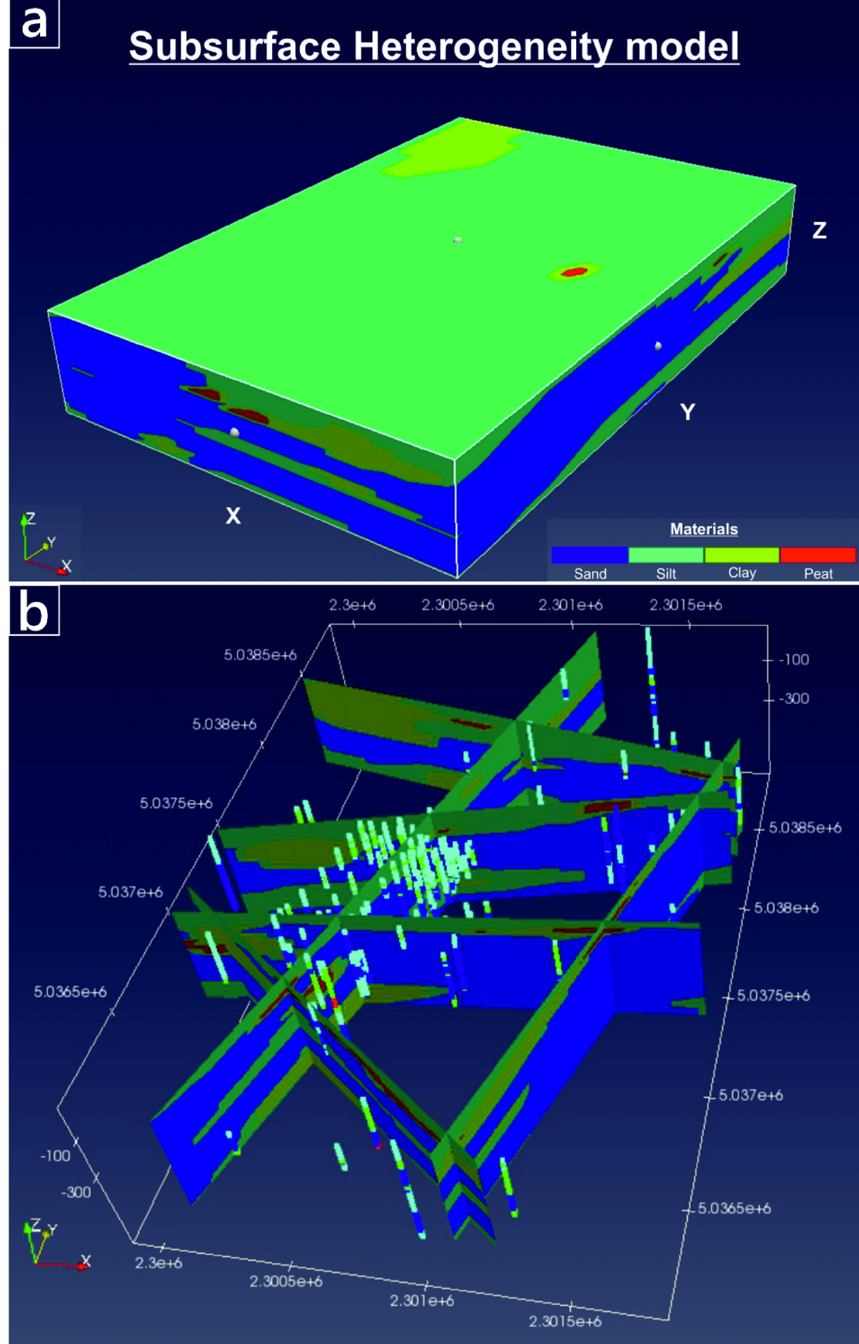
Figure 3. Subsurface lithological model of WAA created using spMC [36]. ( a ) Volume material distribution. ( b ) cross-sections, illustrating the position of the boreholes used to compute the transiograms and to condition the stochastic maps.